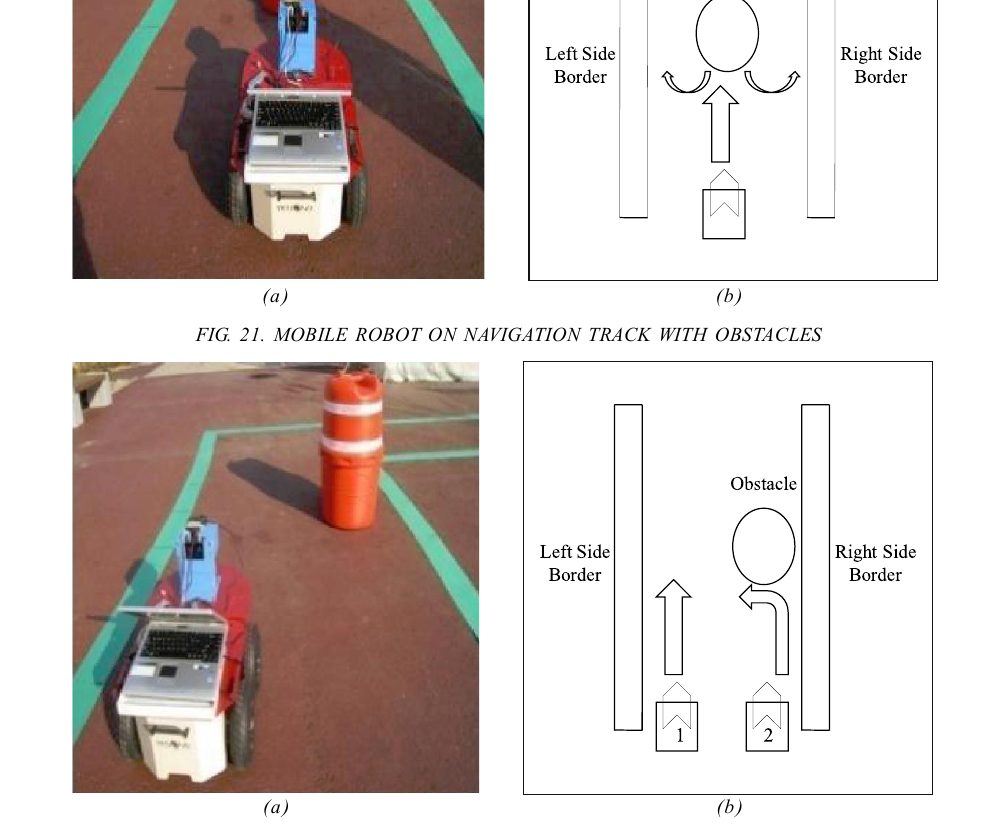
FIG. 22. MOBILE ROBOT ON NAVIGATION TRACK WITH